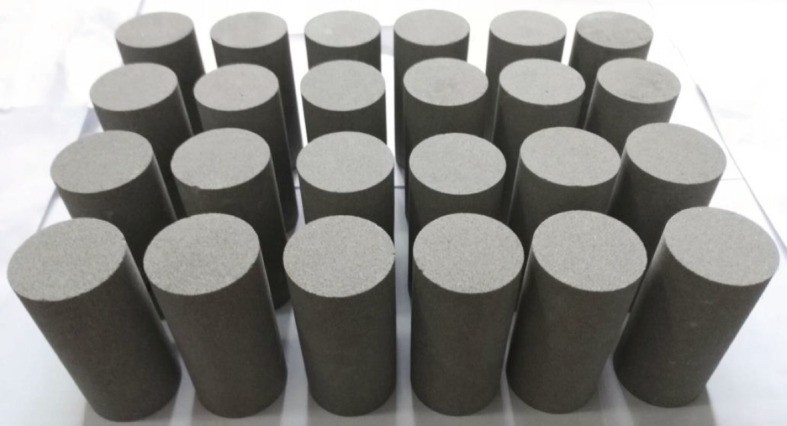
Sandstone specimens.